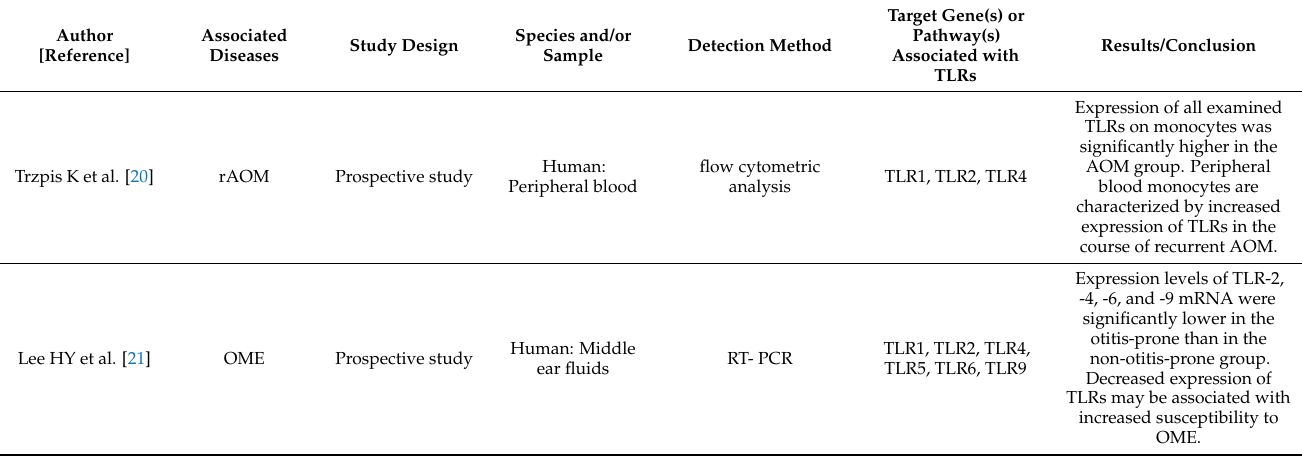
Table 2. Studies assessing the association between otitis media and Toll-like